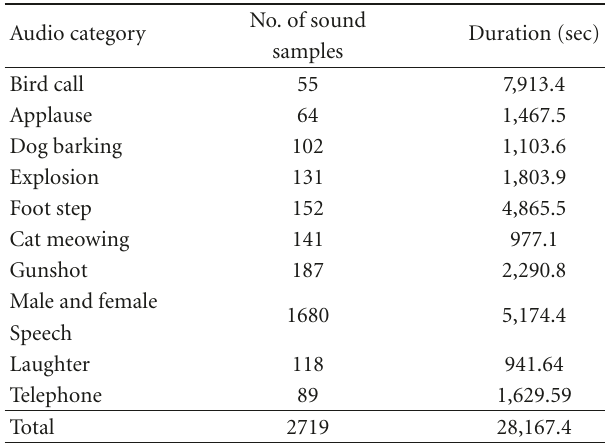
Table 2: Statistics of the final